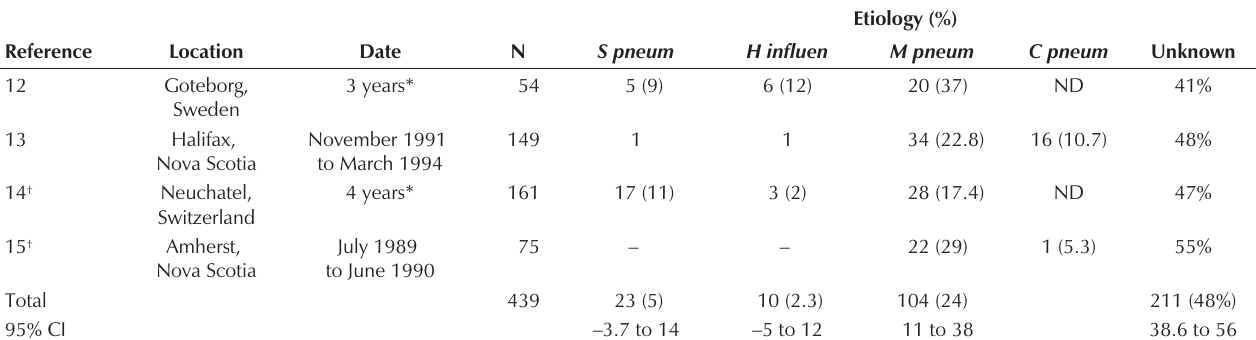
Etiology of community-acquired pneumonia treated on an ambulatory